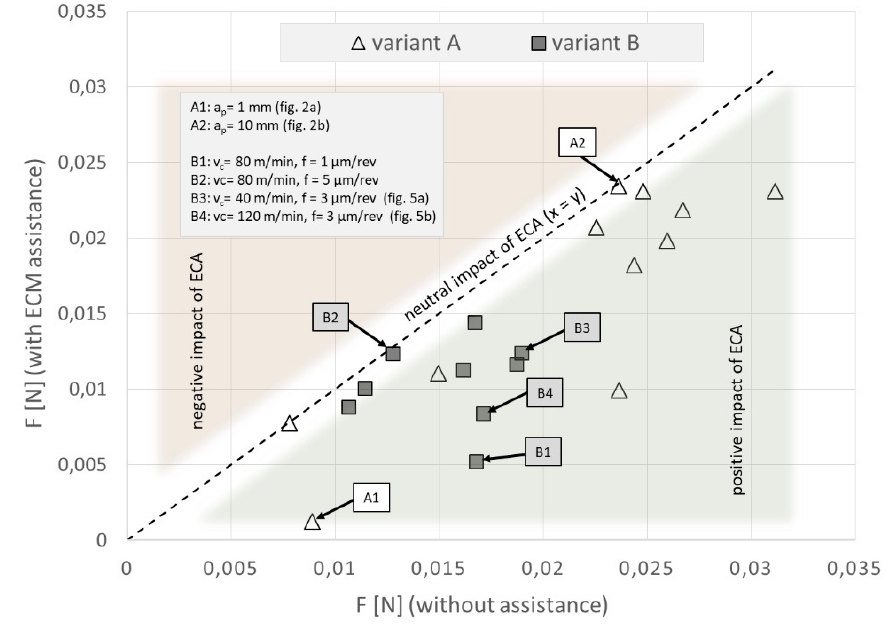
Figure 1. Correlogram presenting the relationship between force sensor load F with and without electrochemical assistance (ECA) for investigated variants of machining.